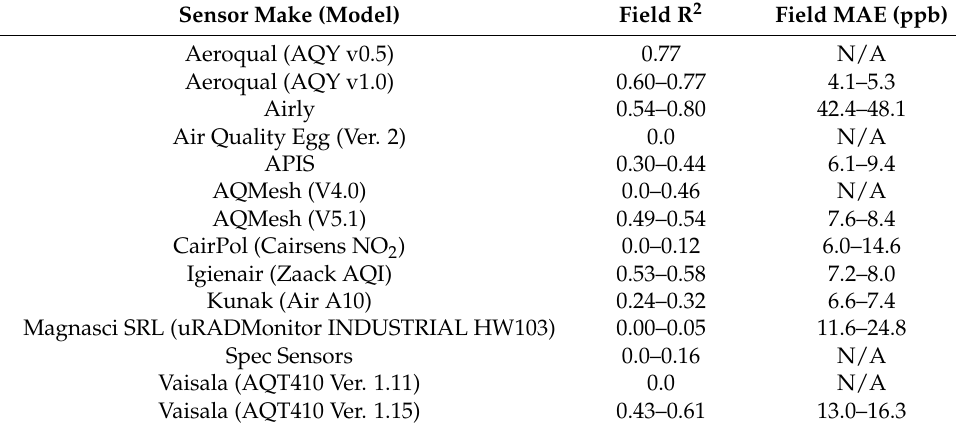
Table 1. Results summary of NO 2 LCSs tested by the South Coast Air Quality Management Dis- trict